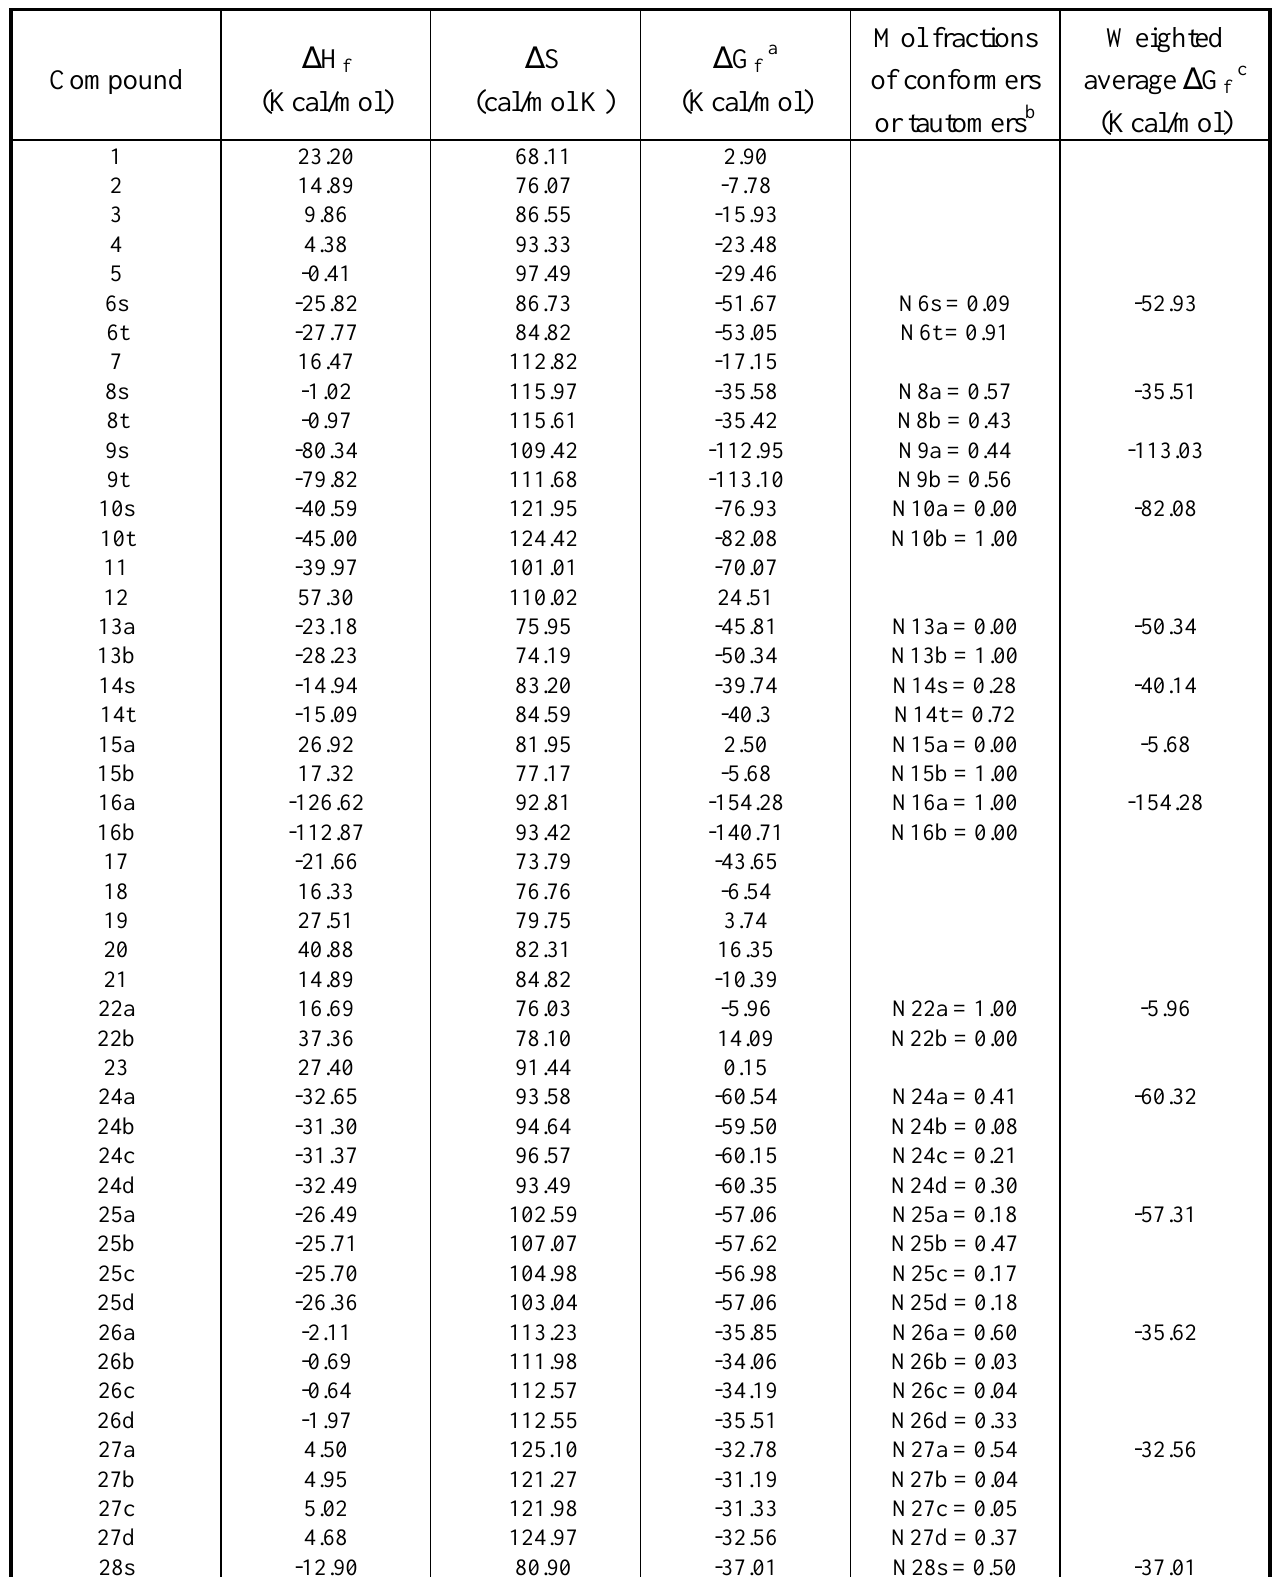
Table 4 . The PM5 calculated thermodynamic properties of pyridine derivatives in aqueous solution ( e